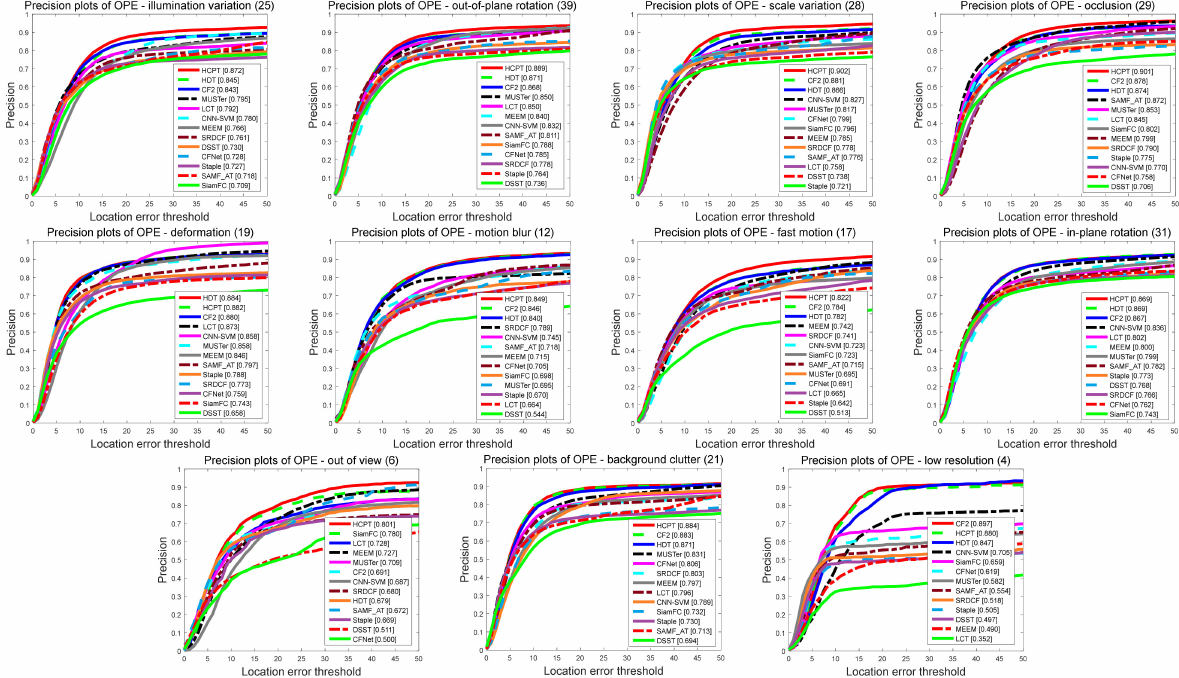
Figure 9. Precision plots of 11 tracking challenging on OTB-2013. The plots illustrate the experimental results using 11 attributes. The legend shows the success rate and we show the results of 12